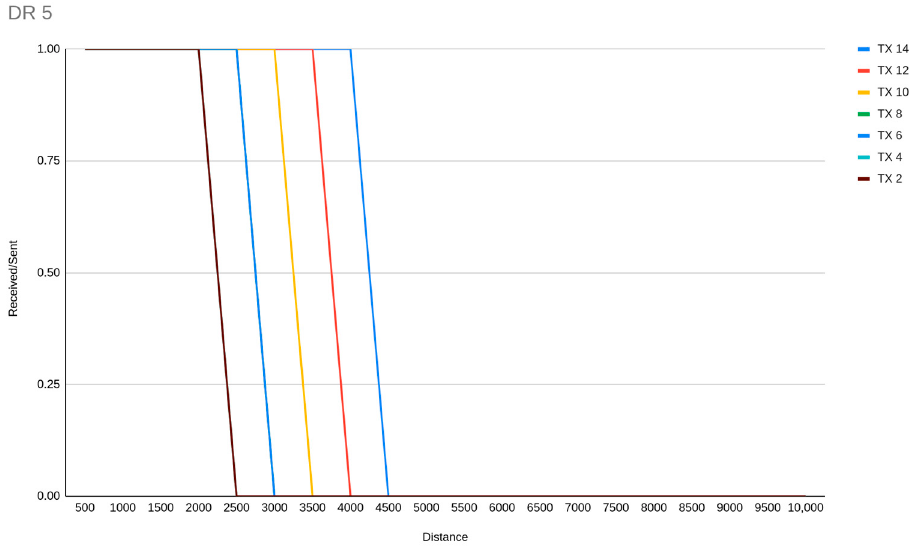
Figure 9. DR5 range of communication with different TX power.